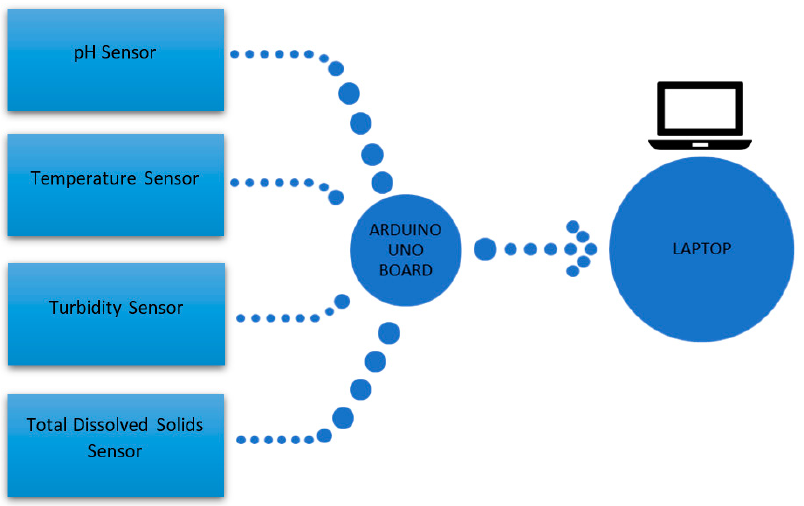
Figure 4. Block diagrams of the connections.